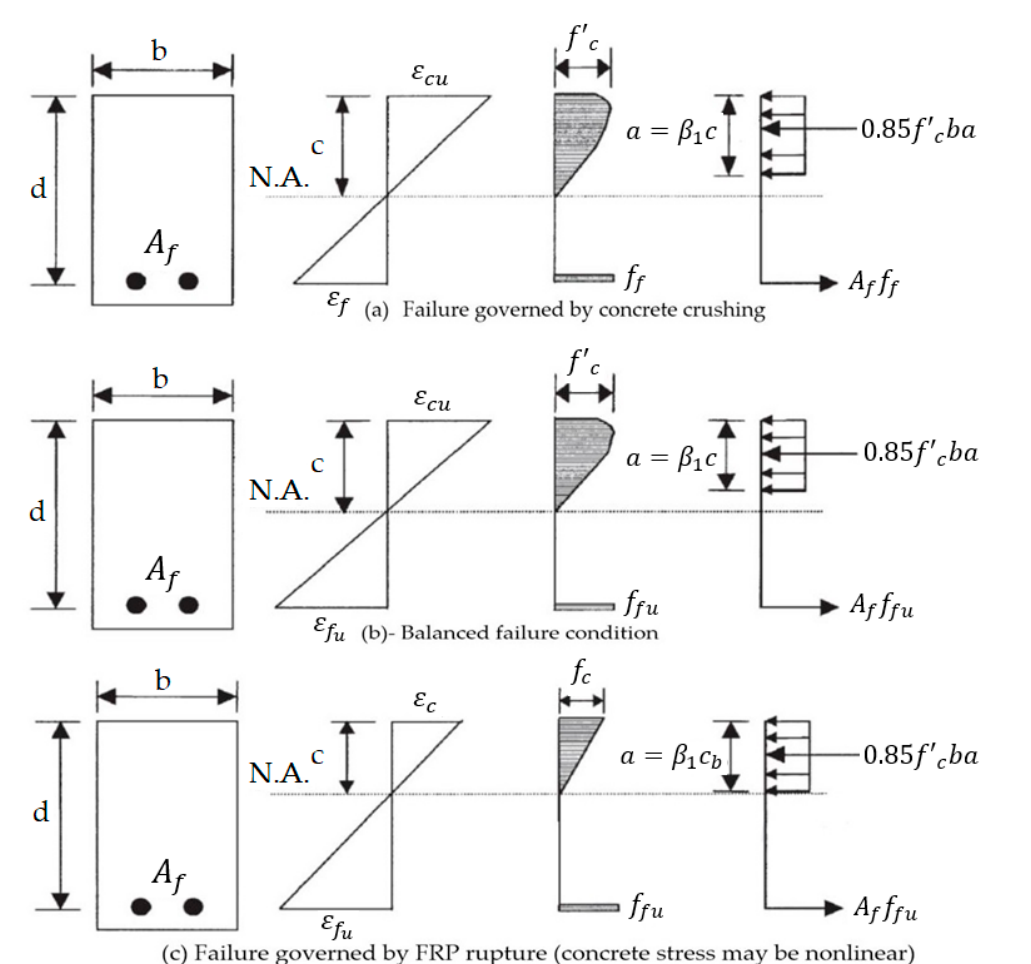
Figure 8. Strain and stress distribution at ultimate conditions [2].